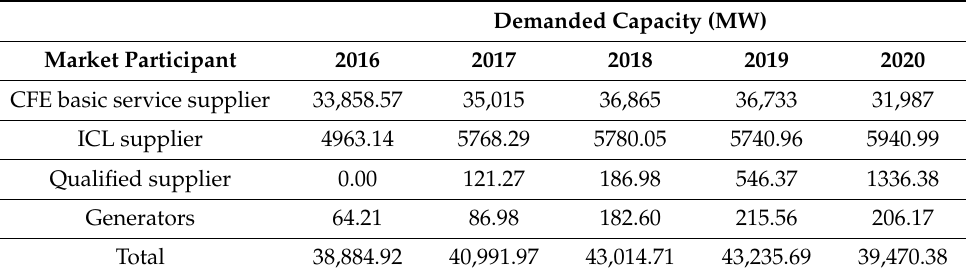
Table 2. Demanded capacity per market participant from 2016 to